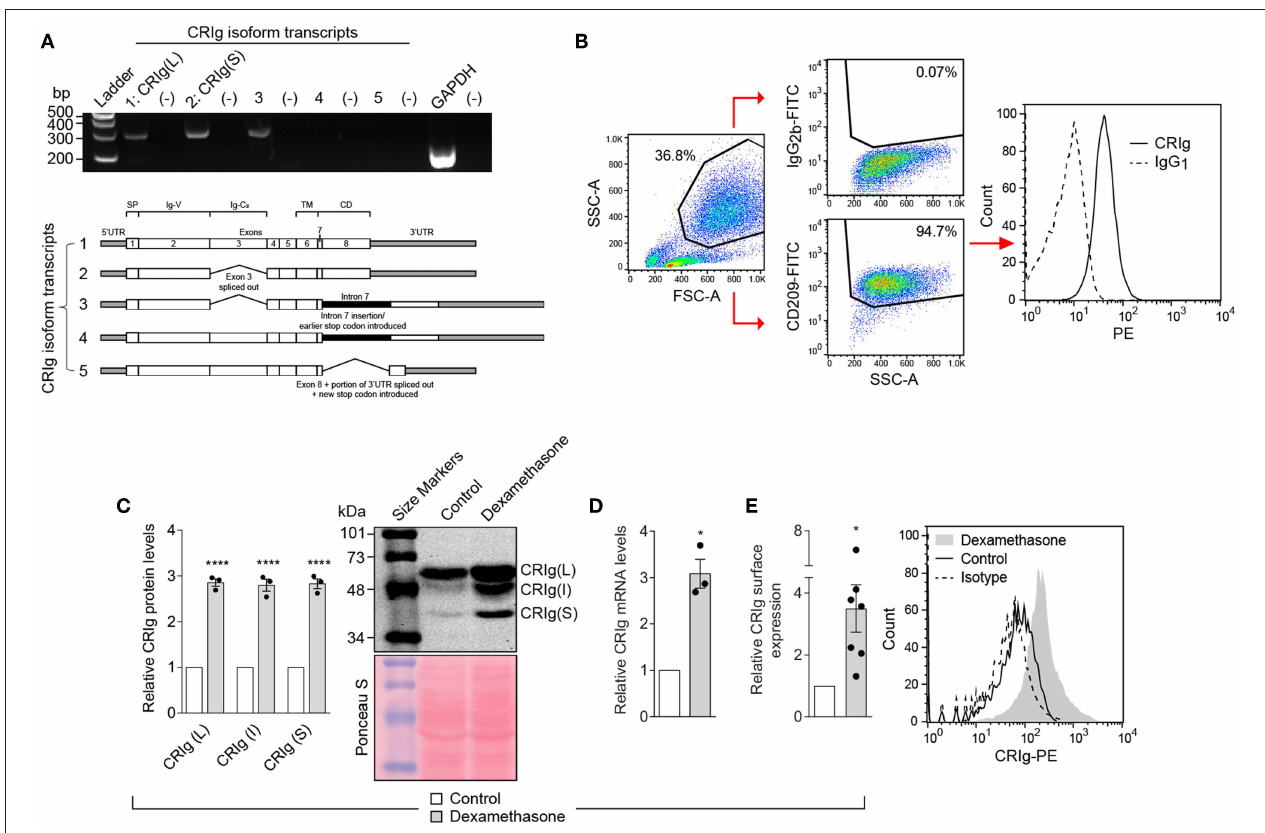
FIGURE 1 | CRIg expression in MDDC and effects of dexamethasone. (A) CRIg isoform transcripts detected in DC. Agarose gel electrophoresis (2%) was used to visualize transcript variant amplicons generated from the cDNA of HMDC. Lanes are labeled 1, 2, 3, 4, and 5 representing each CRIg isoform with (–) to the right of each isoform lane indicating the respective no template controls. GAPDH was a positive control. Gels are representative of three experiments. (B) Gating strategy for CRIg expression on DC by flow cytometry. CD209 + cells were gated before assessing anti-CRIg antibody (6H8-PE) staining; representative histogram shown. (C) CRIg isoform expression by Western blot using anti-CRIg monoclonal antibody (clone 3C9). A representative blot of total protein stained with Ponceau S shows consistency of protein loading. Band intensity for each isoform (L, I, and S) over protein load was determined by densitometry. Data are expressed as fold-change over control DC ( n = 3). (D) Relative CRIg mRNA expression as detected by qPCR, normalized to GAPDH, expressed as fold-change over control DCs ( n = 3). (E) Relative CRIg cell-surface expression by flow cytometry. Data are expressed as fold-change in CRIg-PE (6H8) mean fluorescence intensity minus isotype control (IgG1) of treated over control DCs ( n = 7); representative histogram shown. Data are presented as means ± SEM of experiments conducted with cells from different individuals. Significance levels are indicated by asterisks: * P < 0.05, **** P <